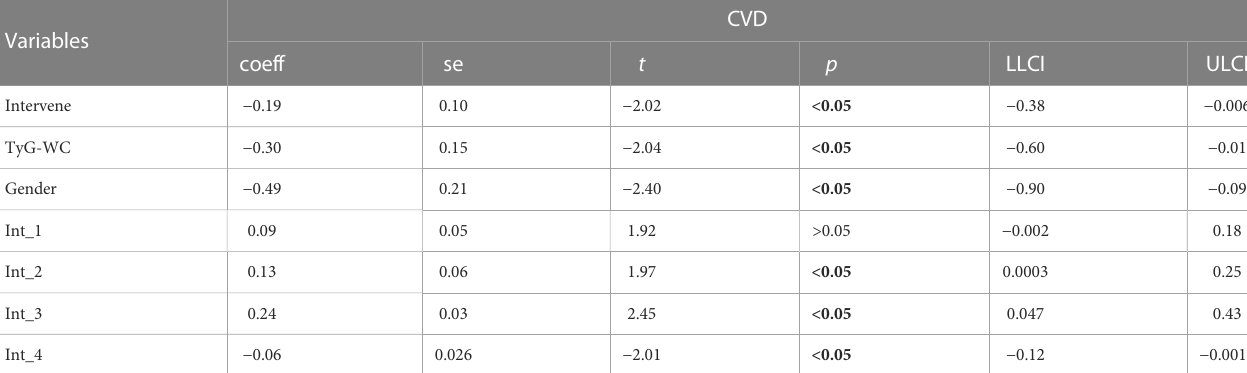
TABLE 19 The moderation analysis between HRBs, TyG-WC, age, and CVD.